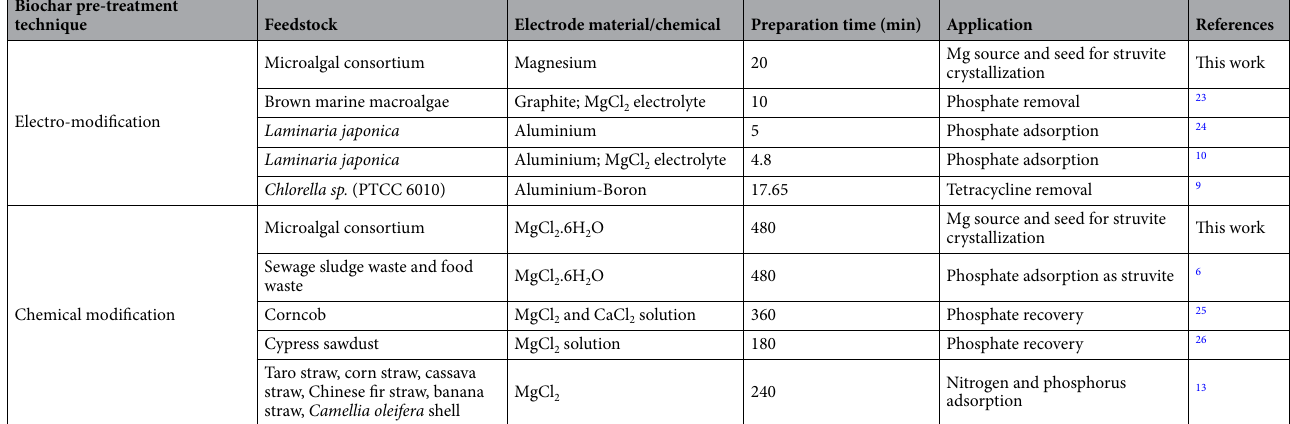
Table 3. Comparison of pre-treatment duration and ion impregnation capacity between electro- and chemical modification techniques and their intended